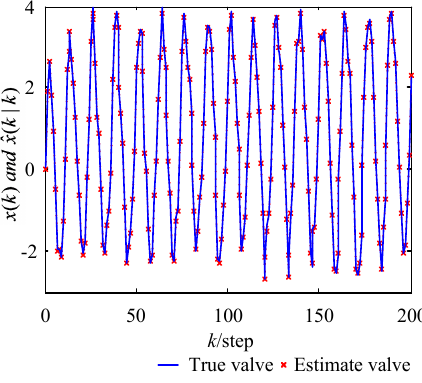
Figure 3. Curves of the true values and estimates using the WMF-PF algorithm based on Gauss–Hermite approximation.